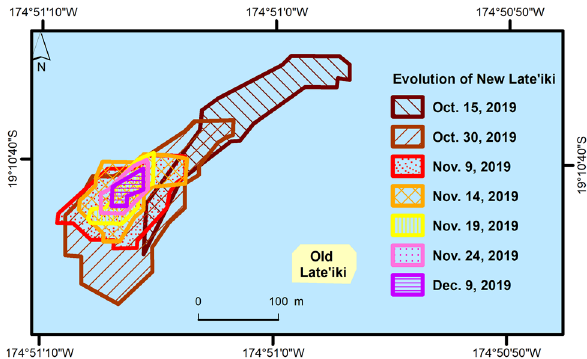
Figure 5. The spatio-temporal evolution of New Late’iki Island as mapped from Sentinel-2 imagery shown in Fig. 2.